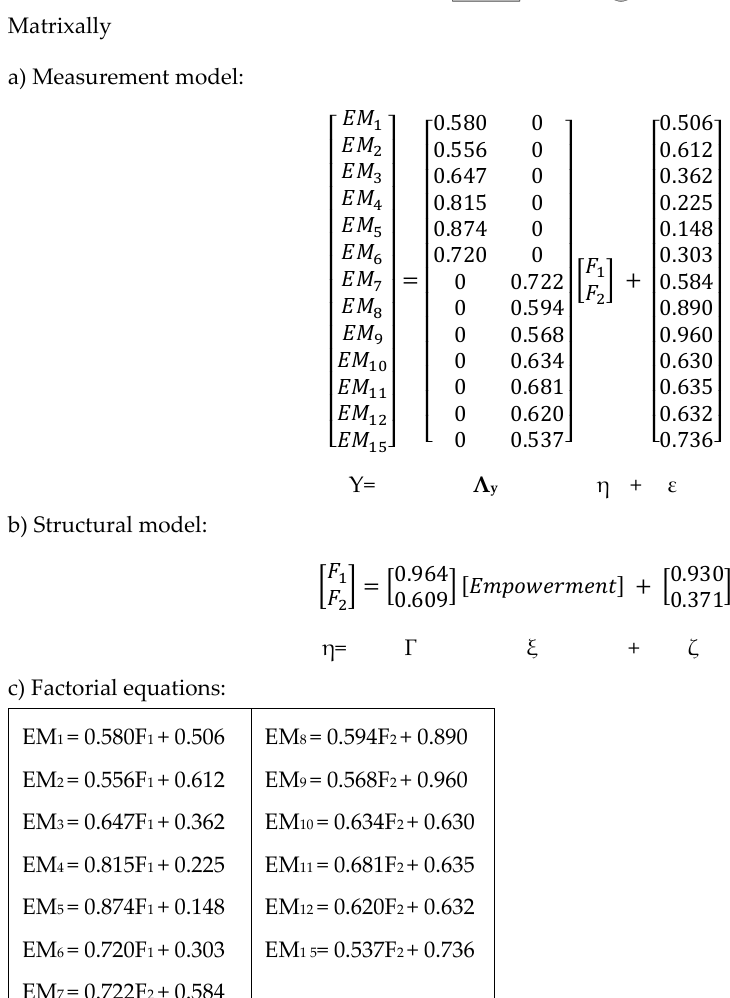
Figure 3. Model 5 of second-order factor structure of the empowerment scale.